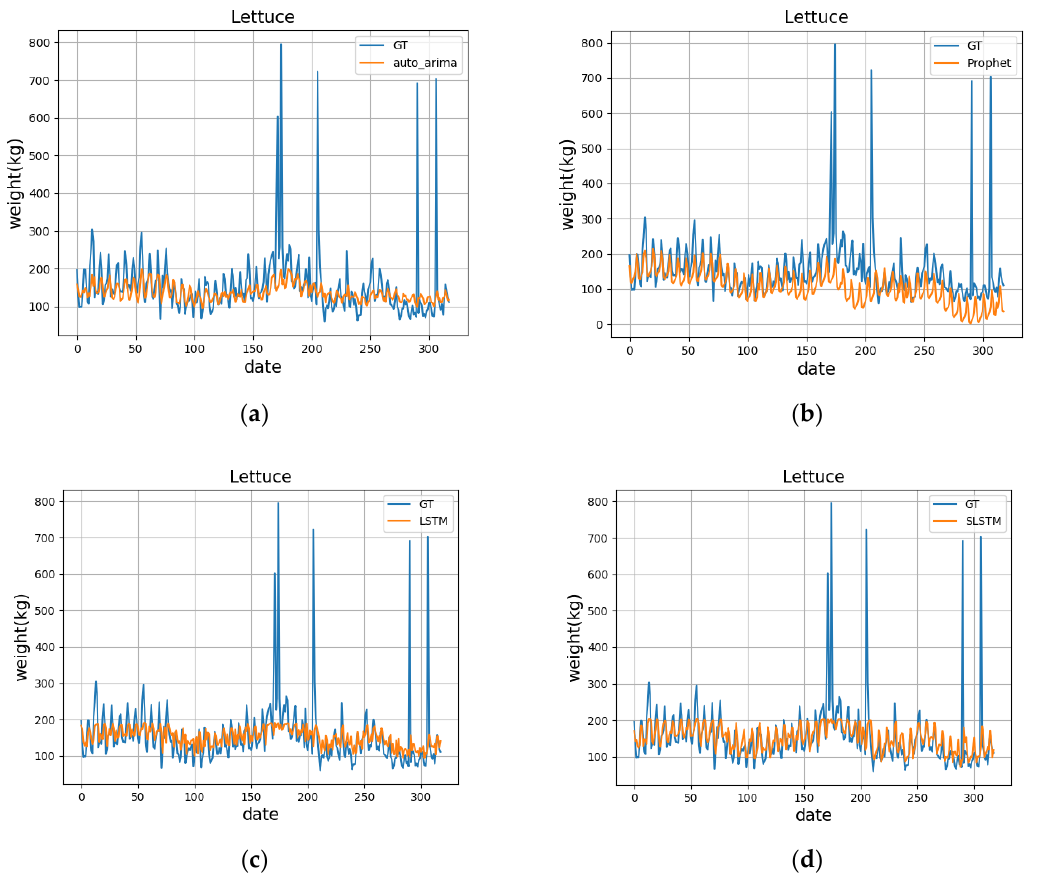
Figure 9. The result predicted by auto_arima ( a ), Prophet ( b ), LSTM ( c ), and SLSTM ( d ) models (only using s w ) with lettuce data.